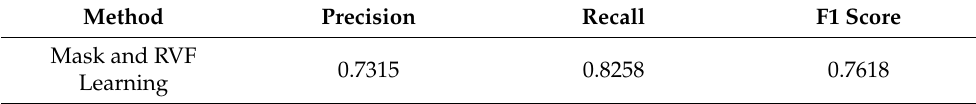
Figure 8. Road Extraction Results Using Mask and RVF Learning. Table 3. The performance evaluation of road extraction using mask learning and RVF.